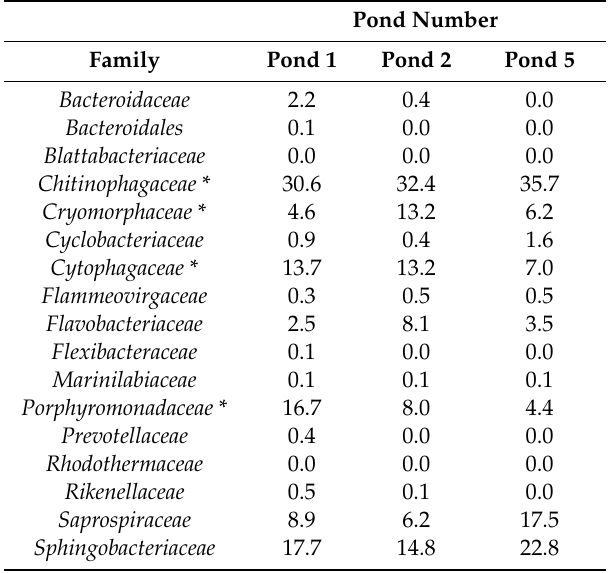
Table A6. Relative abundance for Bacteroidetes families. A * = Pond-indicator family.